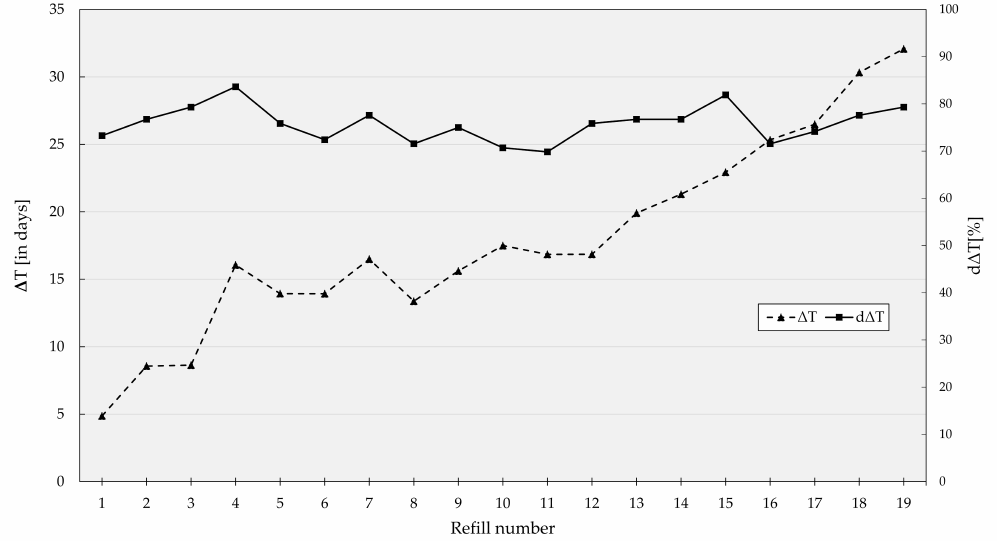
Figure 4. Scatter plots of Δ T (triangle) and d Δ T (square) against the refill number over the period of 19 refills; y -axis in days ( left ) and percent ( right ). 19 refills; y -axis in days ( left ) and percent ( right